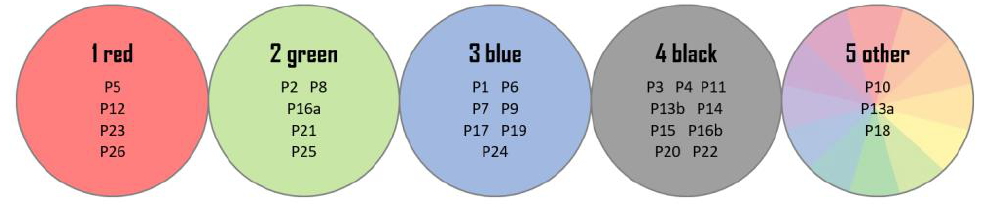
Figure 6. The color groups of fabrics and symbols of the samples belonging to them.